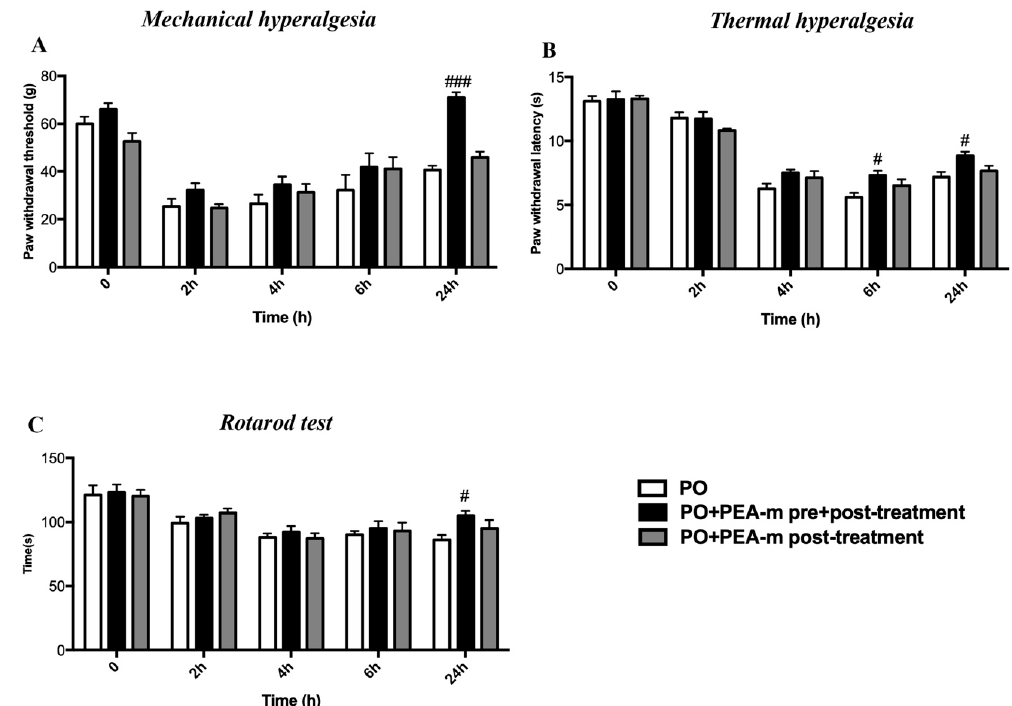
Figure 1. Effects of micronized palmitoylethanolamide (PEA-m) on mechanical allodynia, thermal hyperalgesia, and motor coordination after postoperative pain (PO). ( A ) Mechanical allodynia was measured using the electronic von Frey test before and after postoperative pain induction; ( B ) thermal hyperalgesia was measured using plantar test before and 2, 4, 6, and 24 h after incision; ( C ) motor deficit was measured using the Rotarod test before and 2, 4, 6, and 24 h after hind paw incision. ### p < 0.001 vs. PO; # p < 0.05 vs.